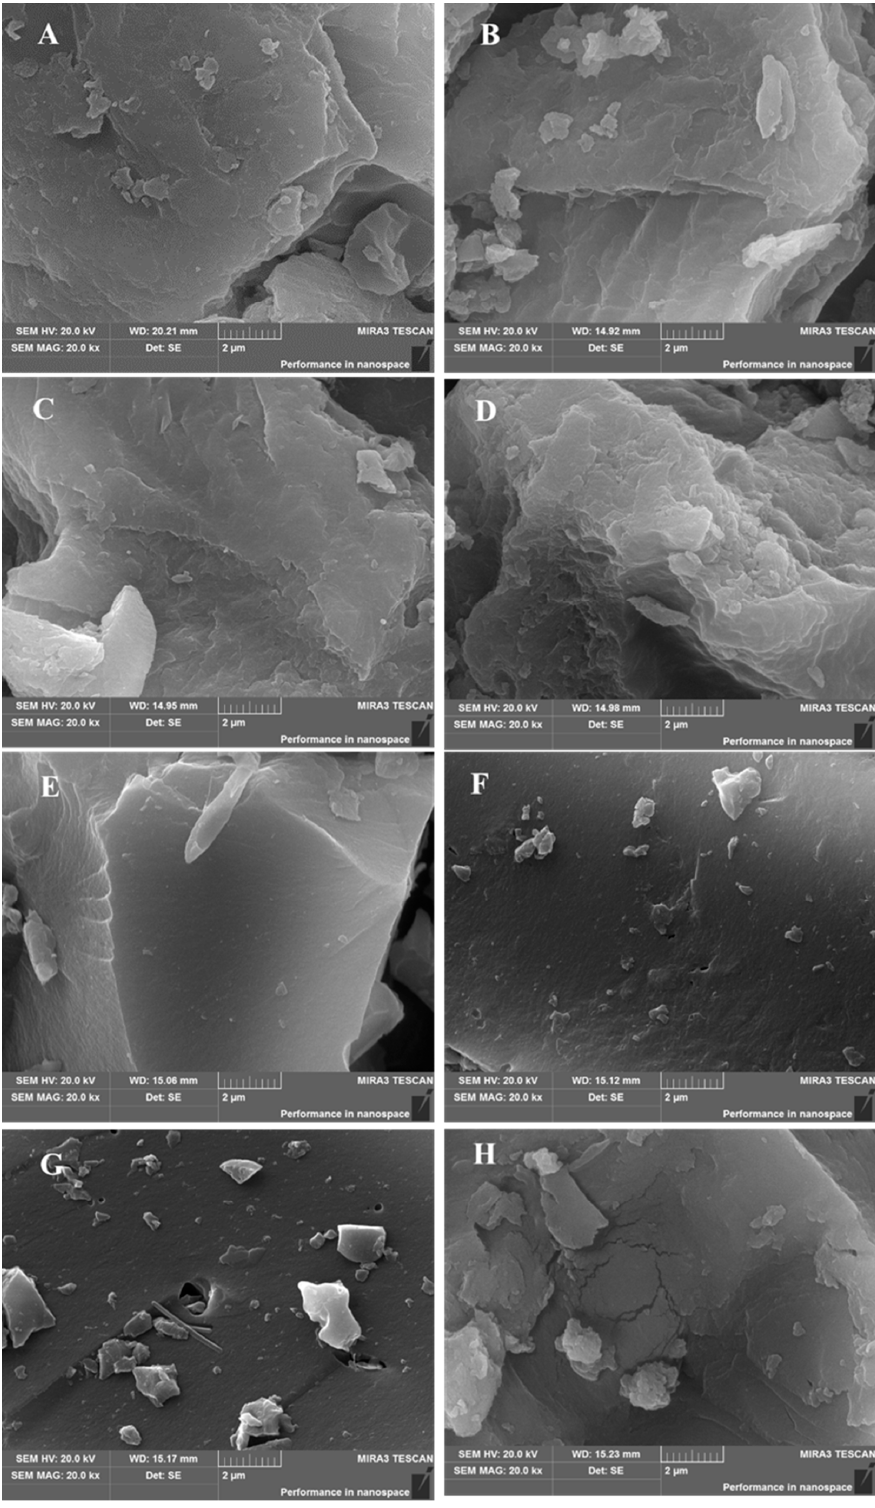
Figure 1. SEM images of BC samples: ( A ) CPP200; ( B ) CPP250; ( C ) CPP300; ( D ) CPP350; ( E ) CPP400; ( F ) CPP450; ( G ) CPP500; ( H ) CPP200, post-adsorption of MB.